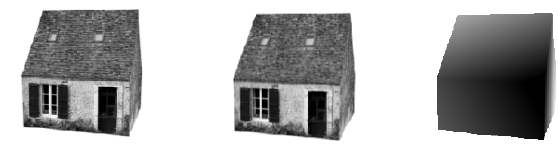
Figure 2: Bergerie1 stereoscopic pair and its ground truth. Characteristics of this benchmark: images size: 1024*1024, disparity range in column: [-22, +9], b/h= 0.04 at the centre, ground truth accuracy of about a hundredth of a pixel.